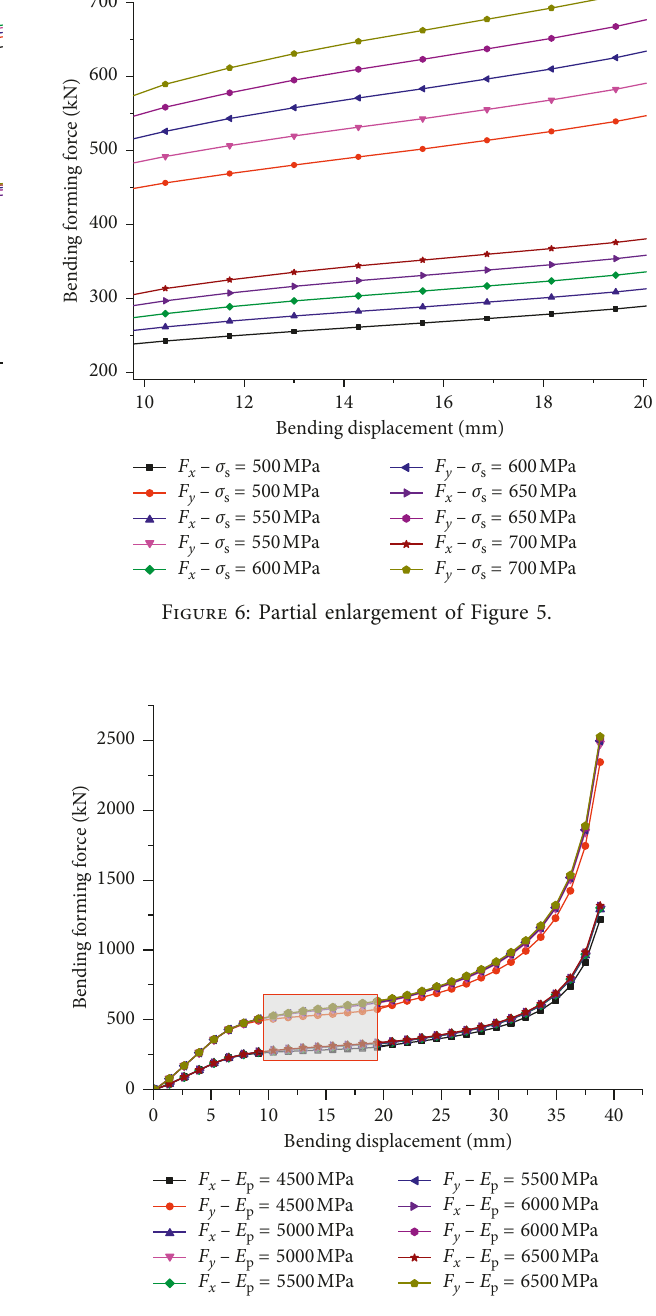
Figure 7: Effects of the plastic modulus on the bending